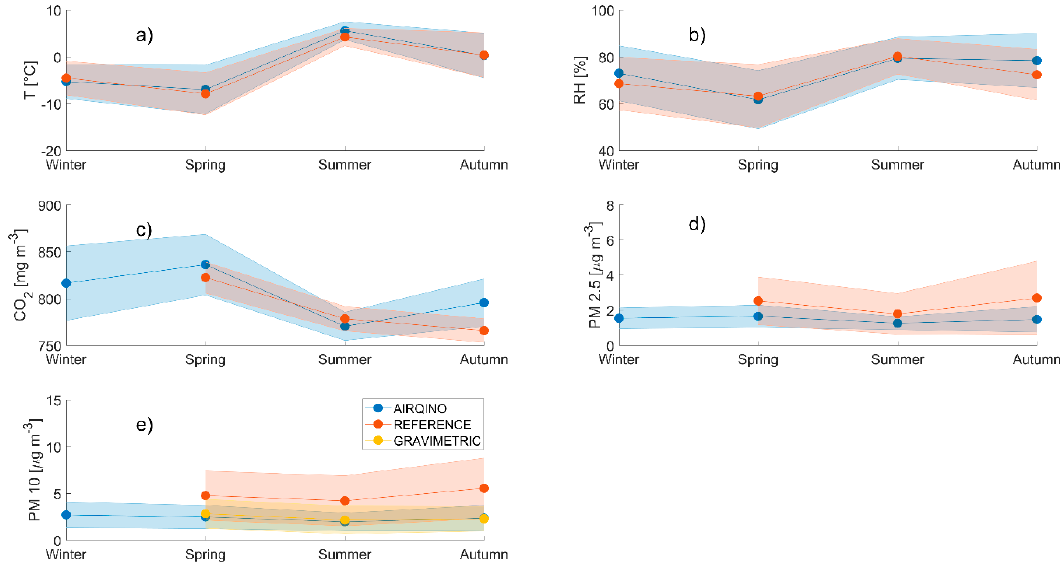
Figure 4. Seasonal trends of air temperature ( a ), relative humidity ( b ), CO 2 ( c ), PM 2.5 ( d ), and PM 10 ( e ) for AIRQino (blue), CCT/GAL (orange), and GAL-GRAV (yellow). Shaded areas represent standard deviation.